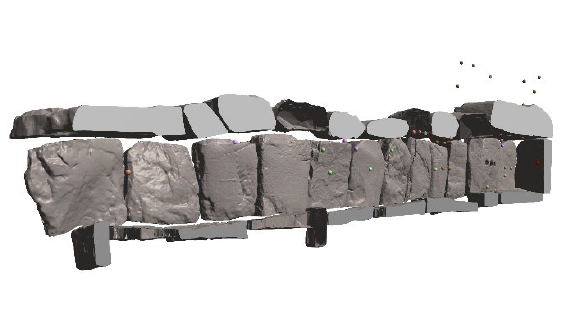
Figure 7. Display of the points of interest: microbiological samples in green, sensors in purple and the remaining of former interventions in orange